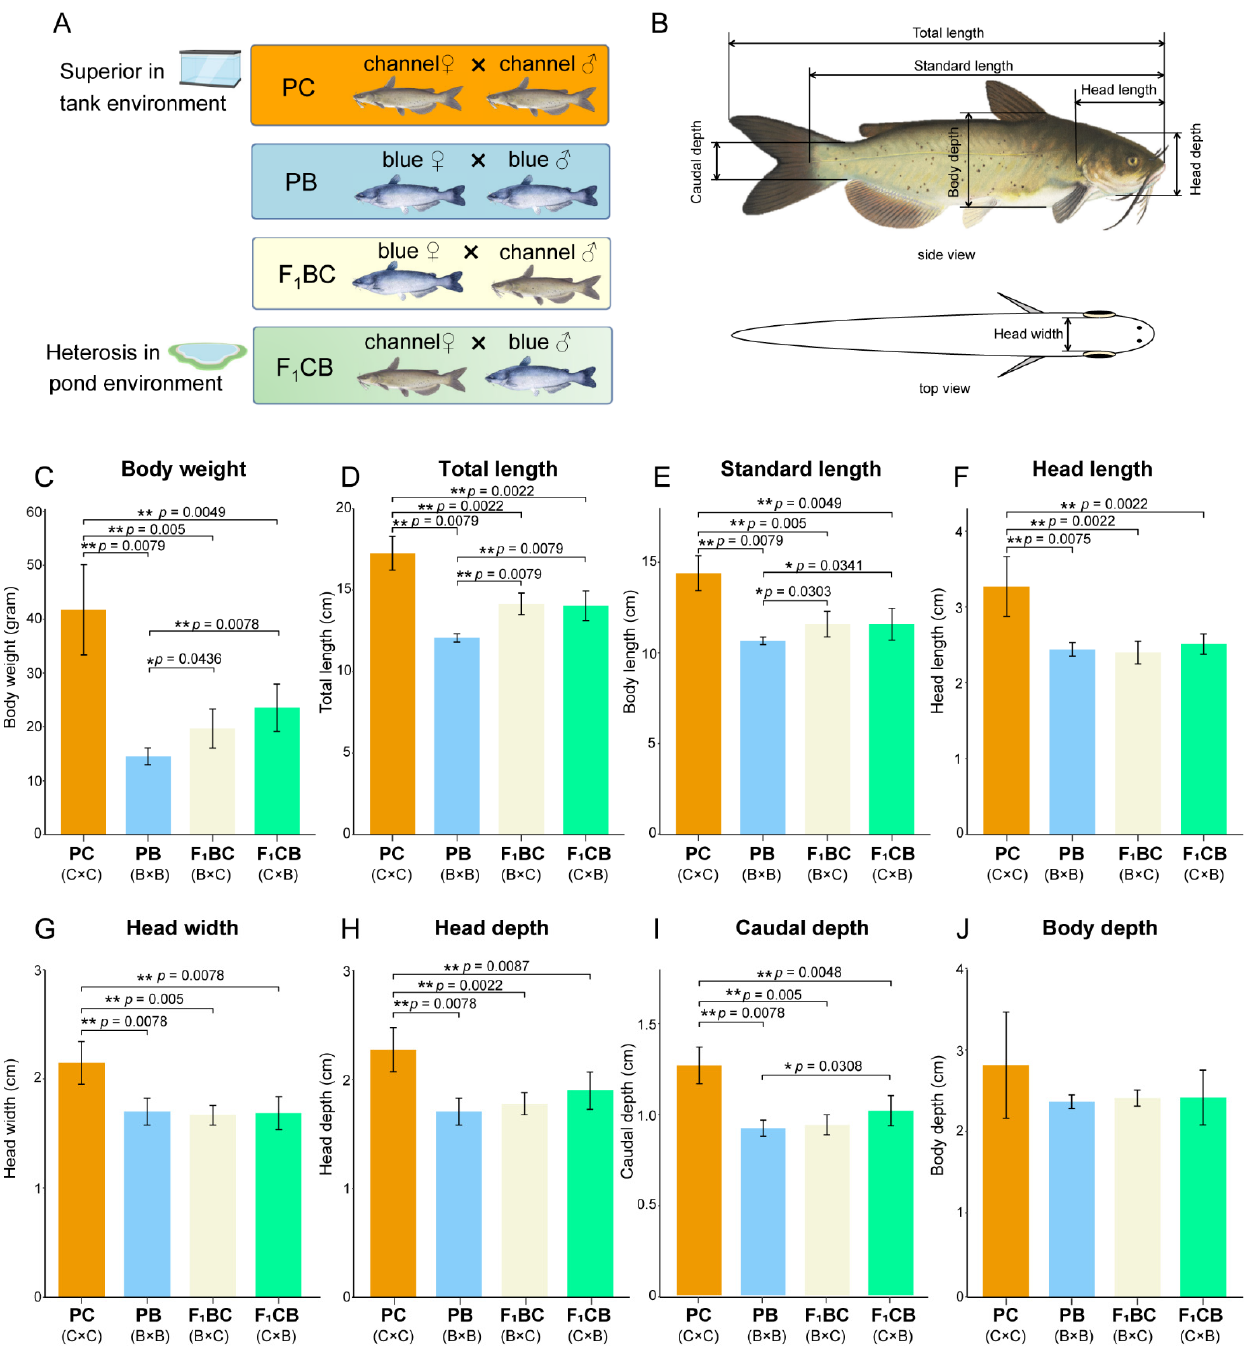
Figure 1. Morphometric measurements of channel catfish (C), Ictalurus punctatus , blue catfish (B), I. furcatus, and their reciprocal F1 hybrids raised in the tank environment. ( A ) Schematic illustration of four genetic cross types: channel catfish (C) parental cross (PC), blue catfish (B) parental cross (PB), blue catfish female × channel catfish male hybrids (F 1 BC), and channel catfish female × blue catfish male hybrids (F 1 CB) ( B ); Morphometric traits measured in this study: body weight ( C ); total length ( D ); body length ( E ); head length ( F ); head width ( G ); head depth ( H ) caudal depth ( I ); and body depth ( J ). Statistical significance was assessed by nonparametric Mann ‐ Whitney U test (*, p < 0.05; **, p < 0.01;). The different colors representing the four genetic types were used consistently in this and subsequent figures.